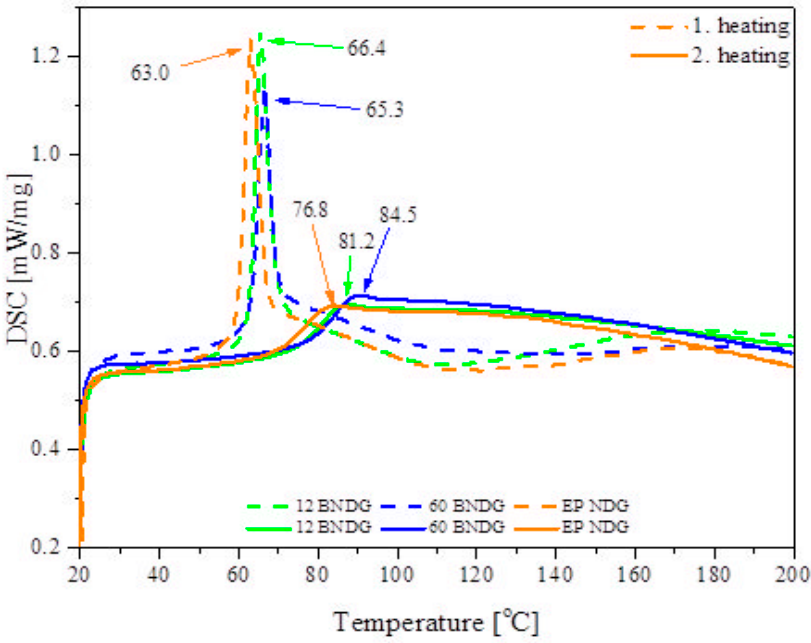
Figure 17. DSC curves recorded for samples of neat epoxy resin, and 12% and 60% BNDG.